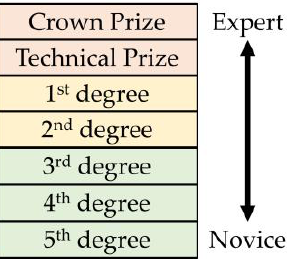
Figure 1. Certification rank of skiing techniques by Ski Association of